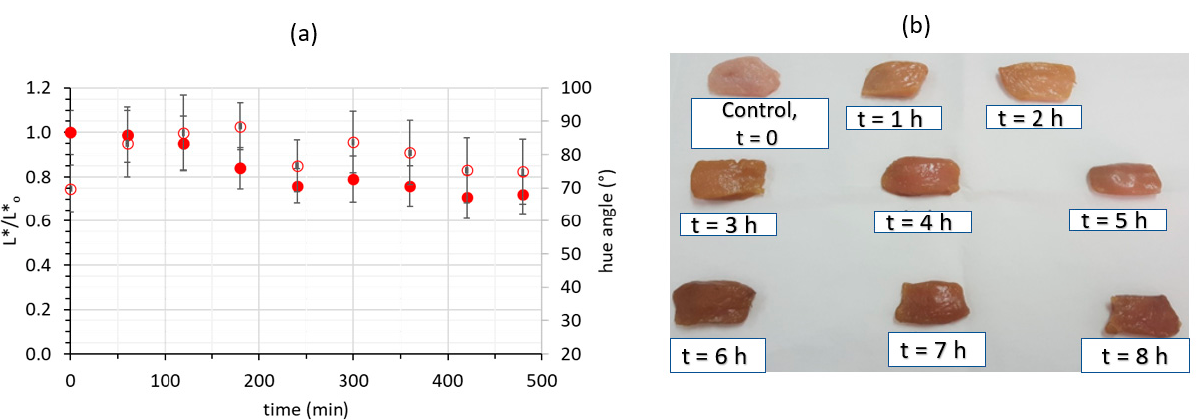
Figure 3. ( a ) Color changes expressed as L*/Lo* (full circles) and hue angle (open circles) during the combined procedure (OV/OD). Error bars represent the ± standard deviation of multiple measurements. ( b ) Representative illustrations of chicken fillet samples during the 8-h OV/OD process.